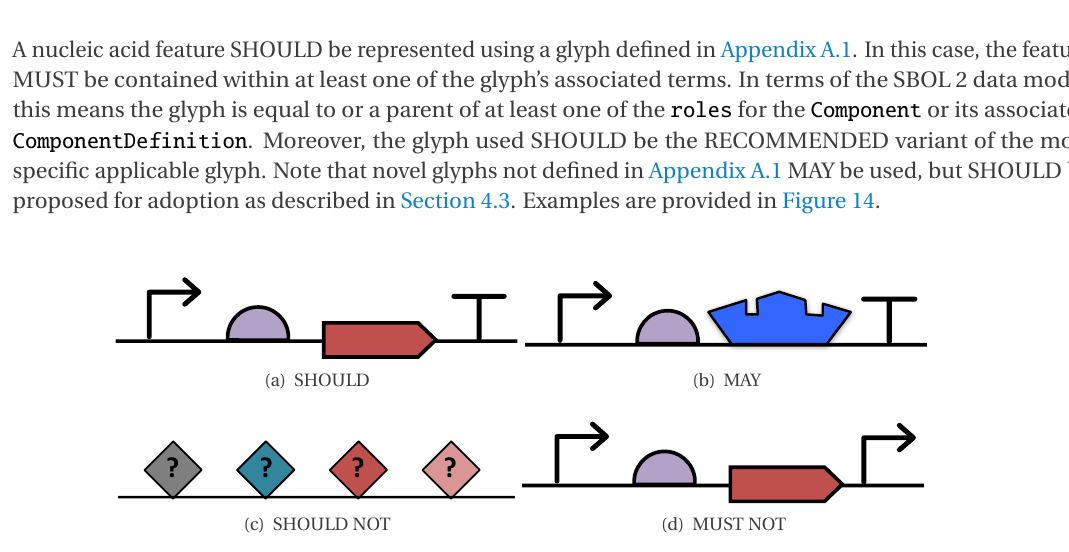
6. A nucleic acid feature SHOULD be represented using a glyph defined in Appendix A.1. In this case, the feature